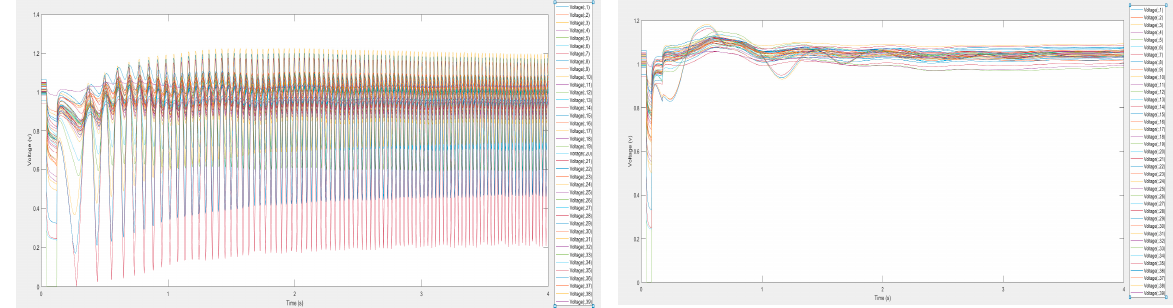
Figure 8. Comparison of voltage curve before and after collaborative transient stability control on fault lines 26–29 of IEEE 39 bus system.